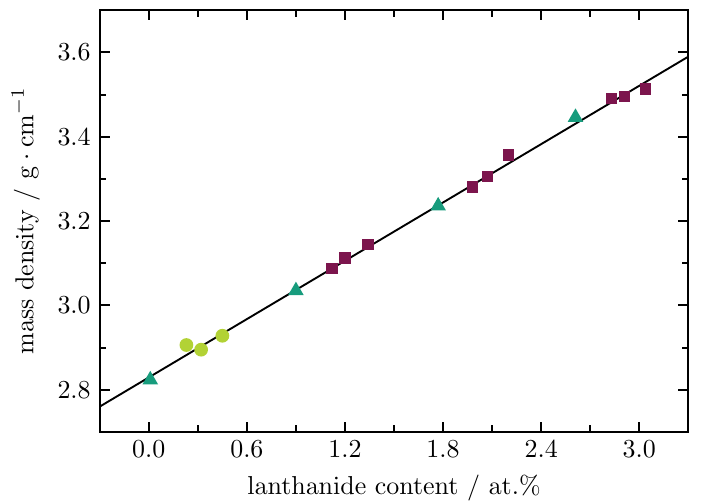
Figure 2. Mass densities of Dy 3 + (full circles) and Tb 3 + (full triangles) single-doped as well as Dy 3 + /Tb 3 + (full squares) double-doped BaB glasses. The solid line represents a least squares fitting to the experimental